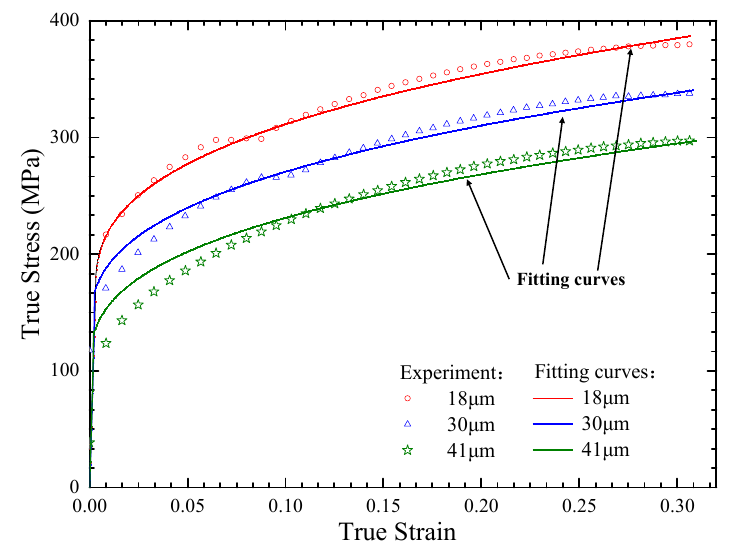
Figure 3. True stress–strain curves for the tensile specimens with thicknesses of 0.1 mm.